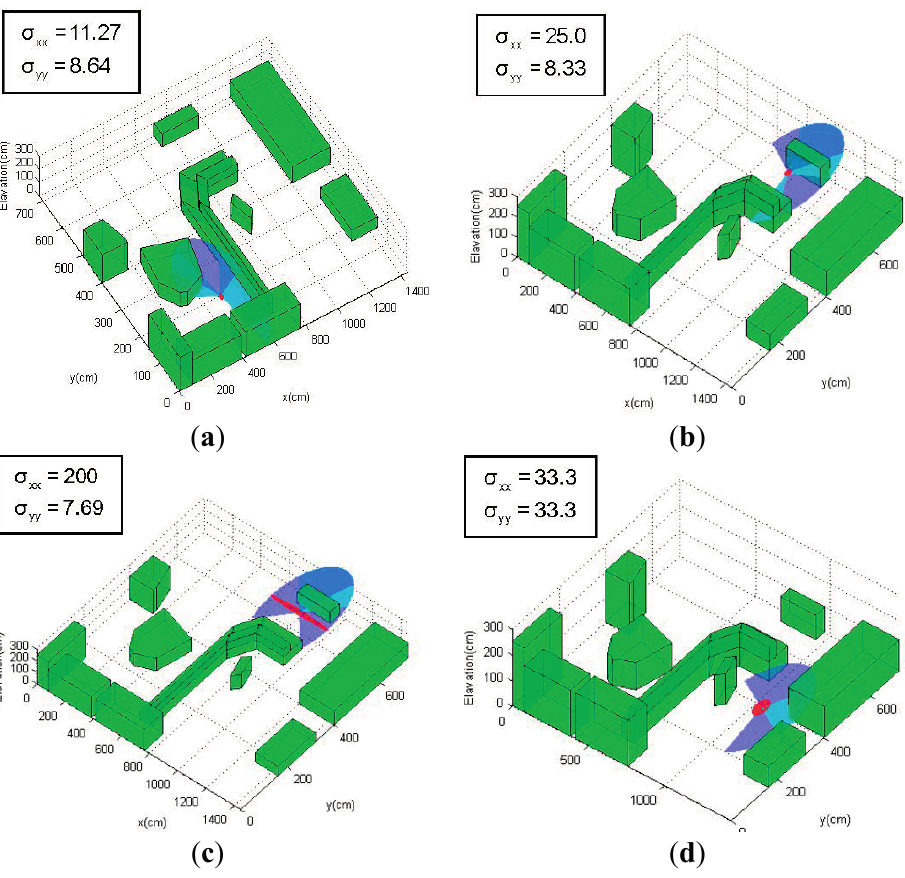
Figure 6. Position estimation uncertainties based on a simulated laser sensor along a predefined path. Cyan sectors denote the laser data with valid environmental measurements. Red ellipses illustrate the 1– σ localization covariance; larger ellipses indicate high uncertainty poses. All covariance are in cm. ( a ) position: (5.0, 2.0, 0.5) m, heading: − 45°; ( b ) position: (8.0, 7.5, 0.5) m, heading: − 45°; ( c ) position: (8.0, 7.5, 0.5) m, heading: 0°; ( d ) position: (11.0, 4.0, 1.0) m, heading: − 30°; ( e ) position: (10.0, 2.5, 1.0) m, heading: